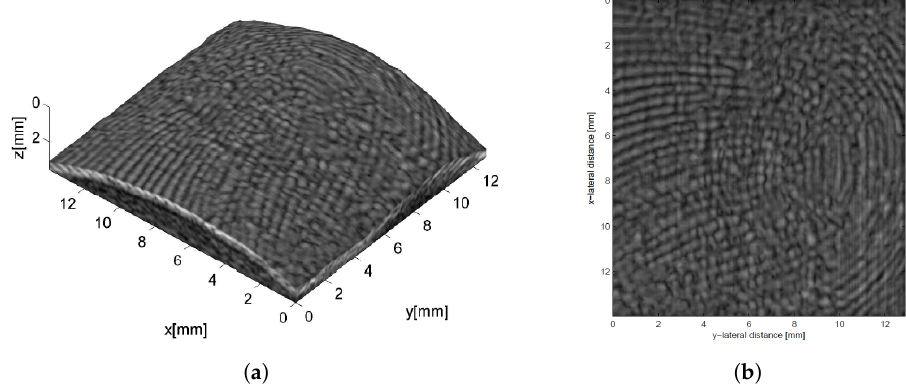
Figure 4. A fingerprint collected by scanning a linear CMUT array along the elevation direction: ( a ) 3D voxel representation, ( b ) 2D image extracted at an under-skin depth of 0.2 mm. In both images, sweat pores are clearly visible. Reprinted with permission from